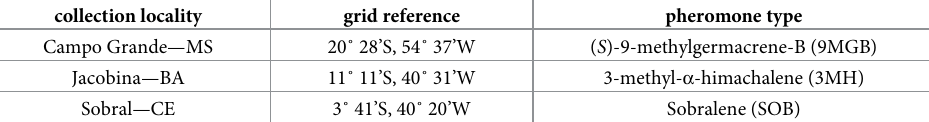
Table 1. Original collection site and pheromone type of the members of the Lu . longipalpis species complex held at Lancaster University used in the study. collection